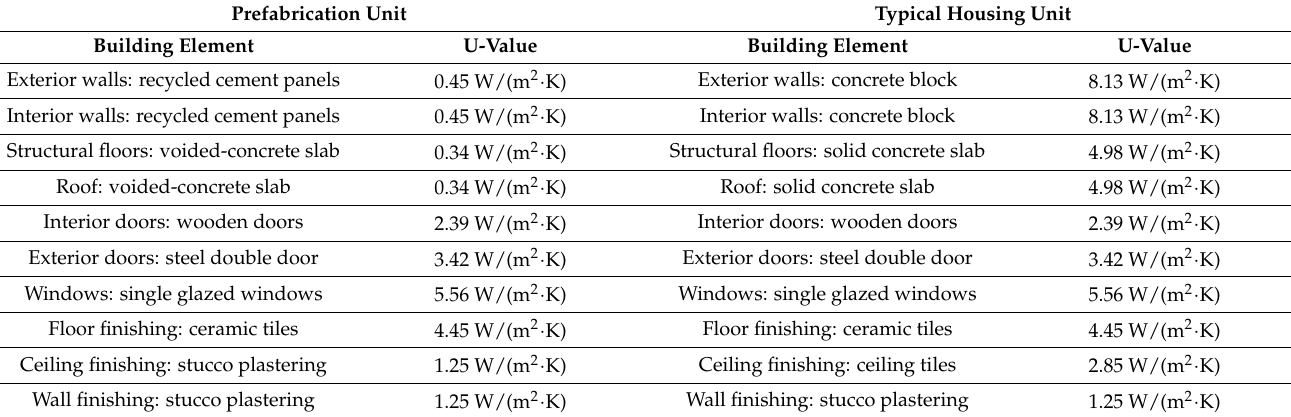
Table 7. Building Specifications: Prefabrication Unit vs. Standard Housing Unit.